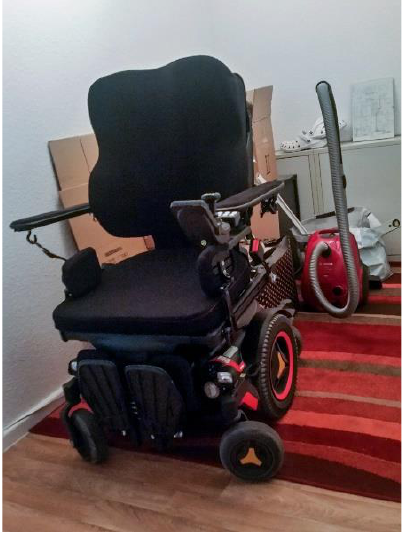
Figure 10. Power